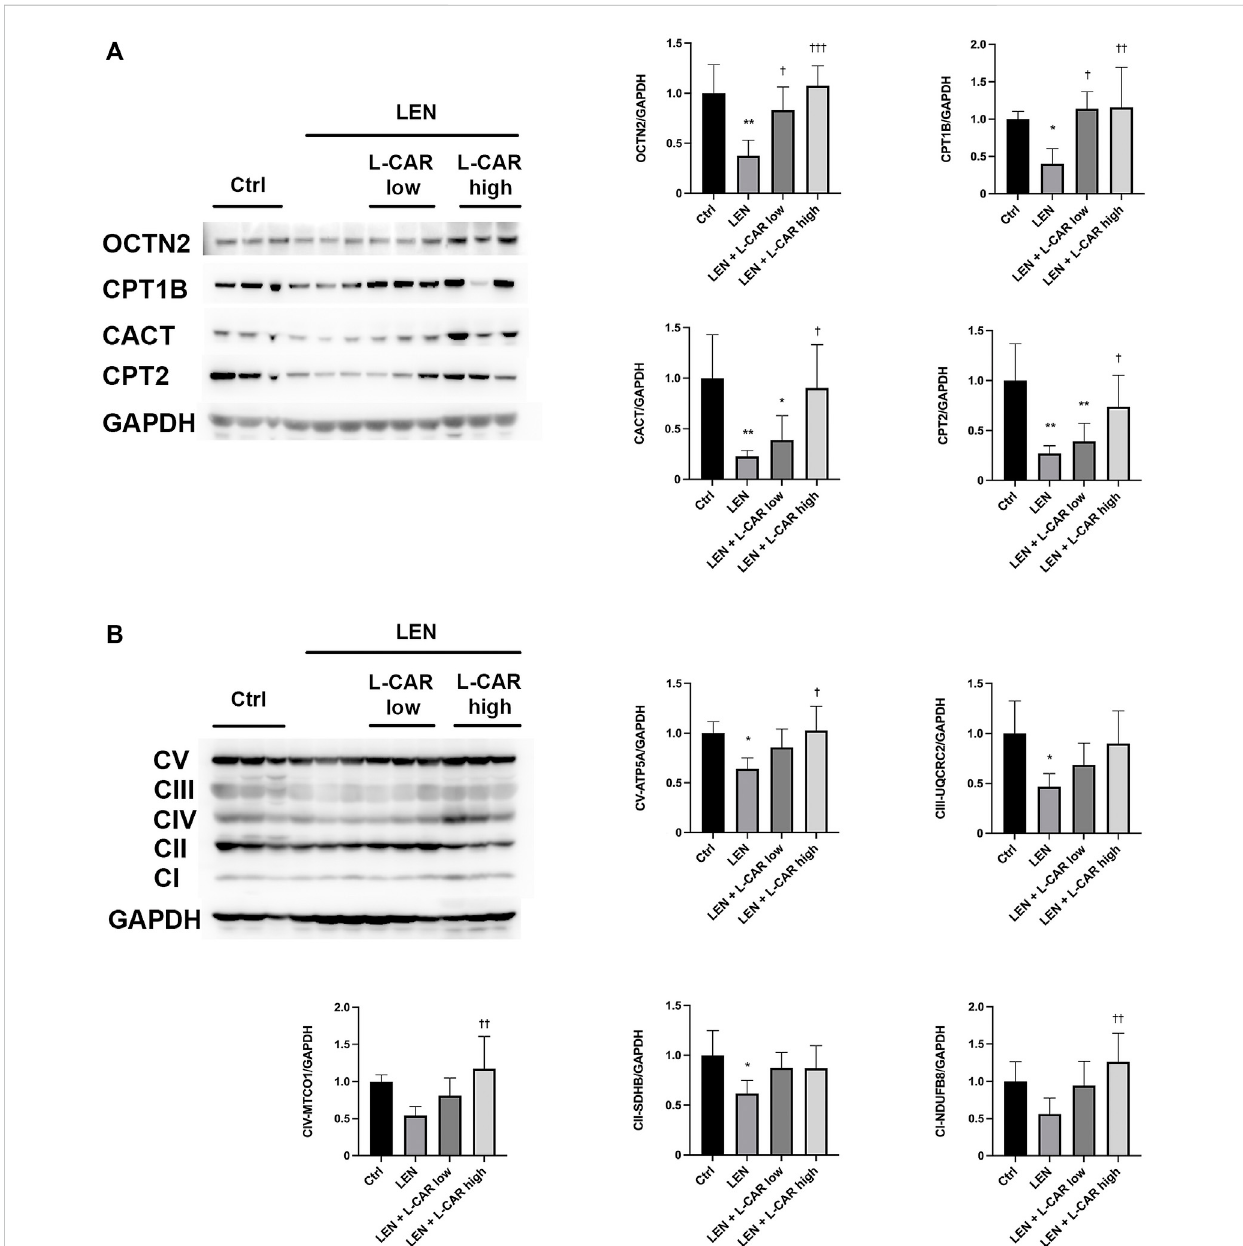
FIGURE 3 Effects of L-carnitine supplementation on the expression levels of carnitine-related (A) and oxidative phosphorylation (OXPHOS) proteins (B) in the skeletalmuscle ofratstreatedwith lenvatinib. Therepresentativewesternblotimagesare shownintheleftpanel.Data arepresentedas themean+SDof experiments in 5 – 6 rats. * p < 0.05, ** p < 0.01 vs . Ctrl group; † p < 0.05, †† p < 0.01, ††† p < 0.001 vs. LEN